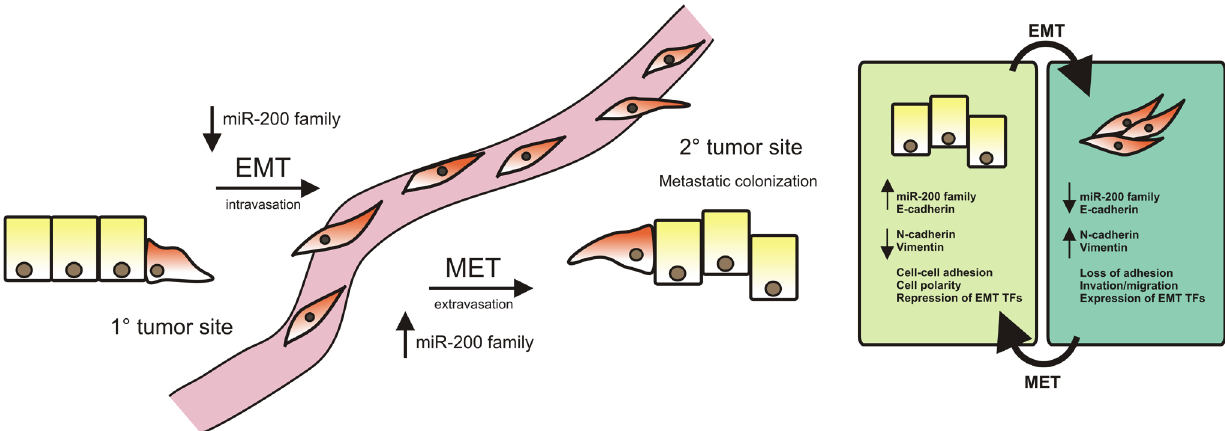
Figure 2. miR-200 family expression in EMT and MET. In EMT, expression of EMT transcription factors (TFs) leads to increased expression of mesenchymal markers and decreased expression of epithelial markers, followed by down-regulation of the cell adhesion and loss of polarity. With increased migration/invasion these mesenchymal-like cancer cells enter the blood or lymphatic vessels and travel to a secondary site, where they go through MET to form metastatic colonization. During the initial phase of local tumor growth, the miR-200 members maintain epithelial integrity and can thus suppress or reverse cancer progression. In contrast, once the disease has spread to distant organs, miR-200 may potentially accelerate tumor progression by facilitating re-adaptation of the epithelial phenotype and